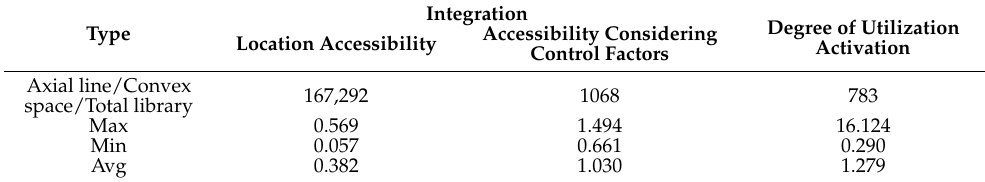
Table 3. Urban hierarchy actuality in Seoul.